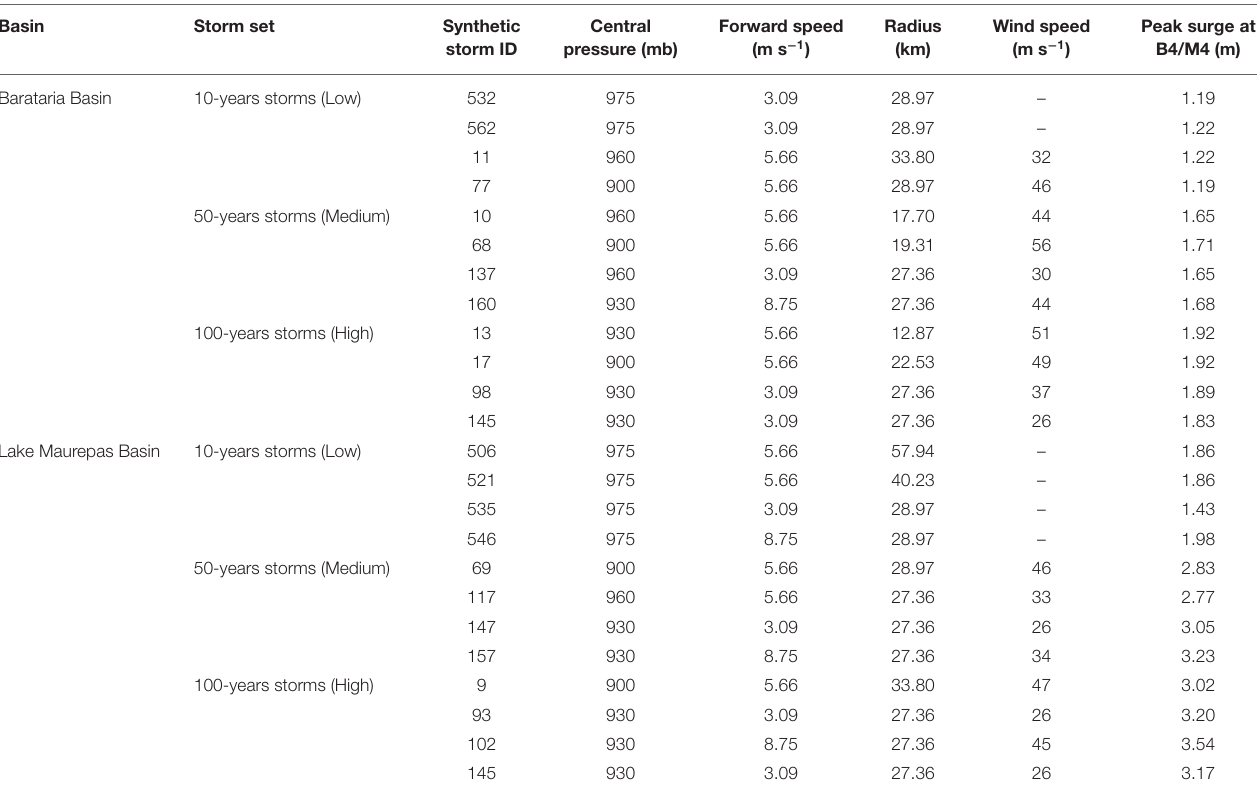
TABLE 2 | Synthetic storm parameters. Basin Storm set